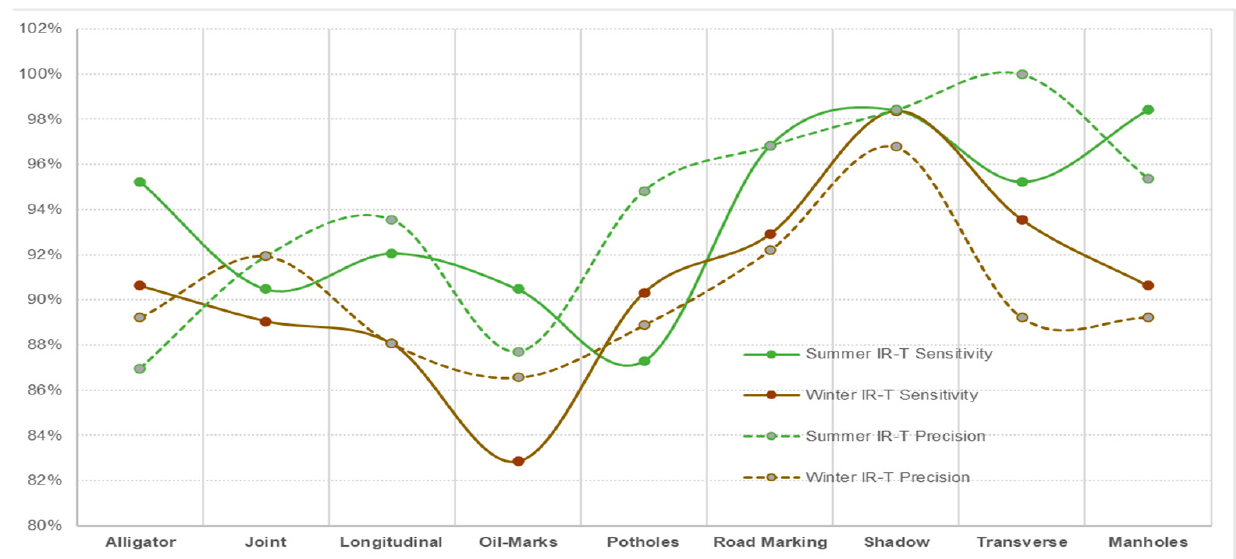
Figure 15. Comparing summer and winter conditions for DC images.